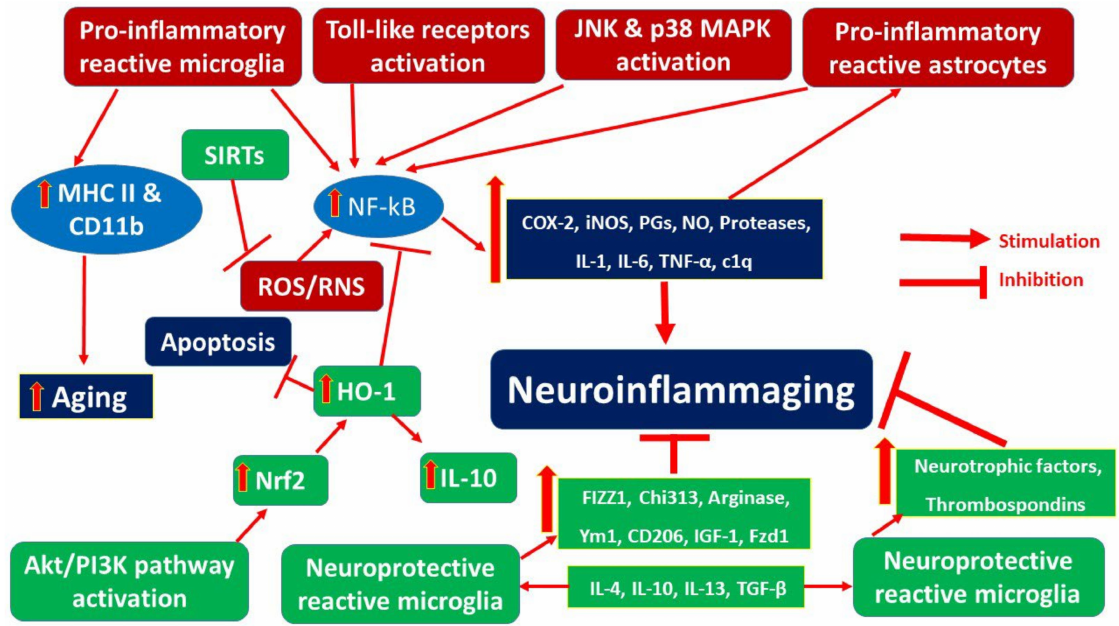
Figure 2. Molecular perspective of